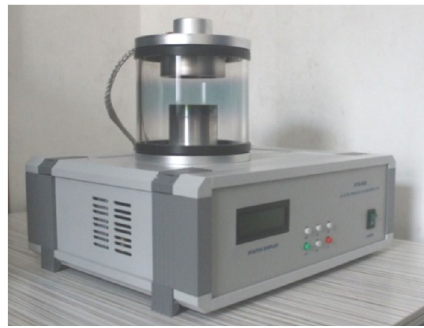
Figure 6. Sputter coater.